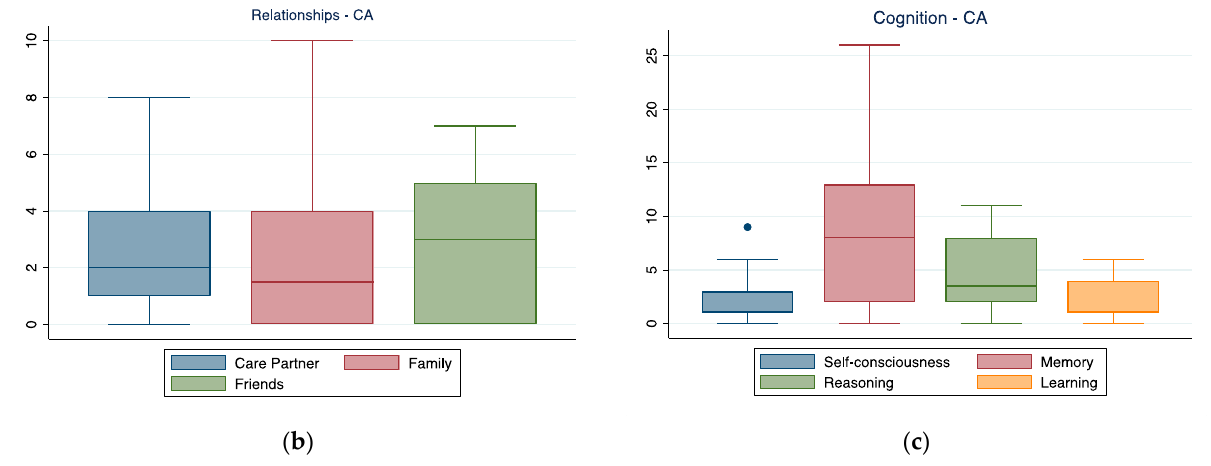
Figure 3. Social and cognitive processes (( a ) Psychological processes; ( b ) relationships; ( c ) cognition) reflected by the participants’ narrations. In the boxplot, the central horizontal line indicates the median, the other two lines indicate the first (lower line) and third (higher line) quartiles, the whiskers indicate the minimum and maximum values, and the dots indicate outliers.